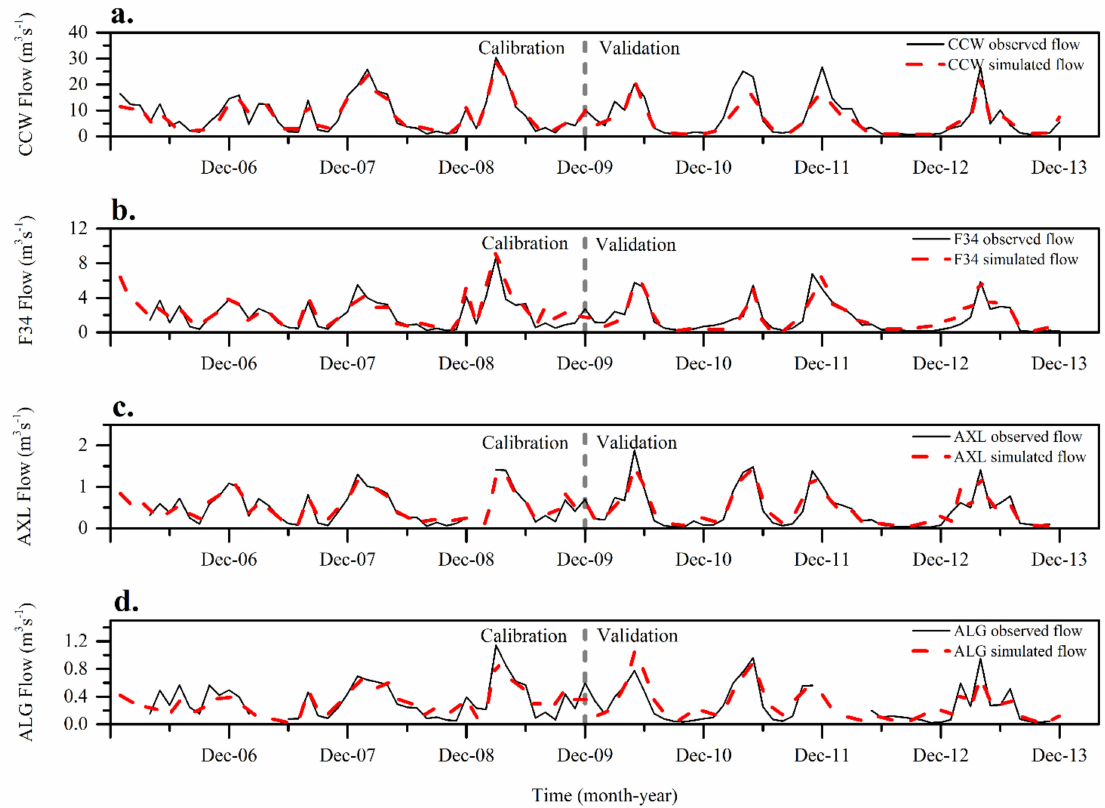
Figure 2. Monthly time series of simulated and observed streamflow for ( a ) CCW, ( b ) F34, ( c ) AXL, and ( d ) ALG. Calibration period was from January 2006 to December 2009 and the validation period was from January 2010 to December